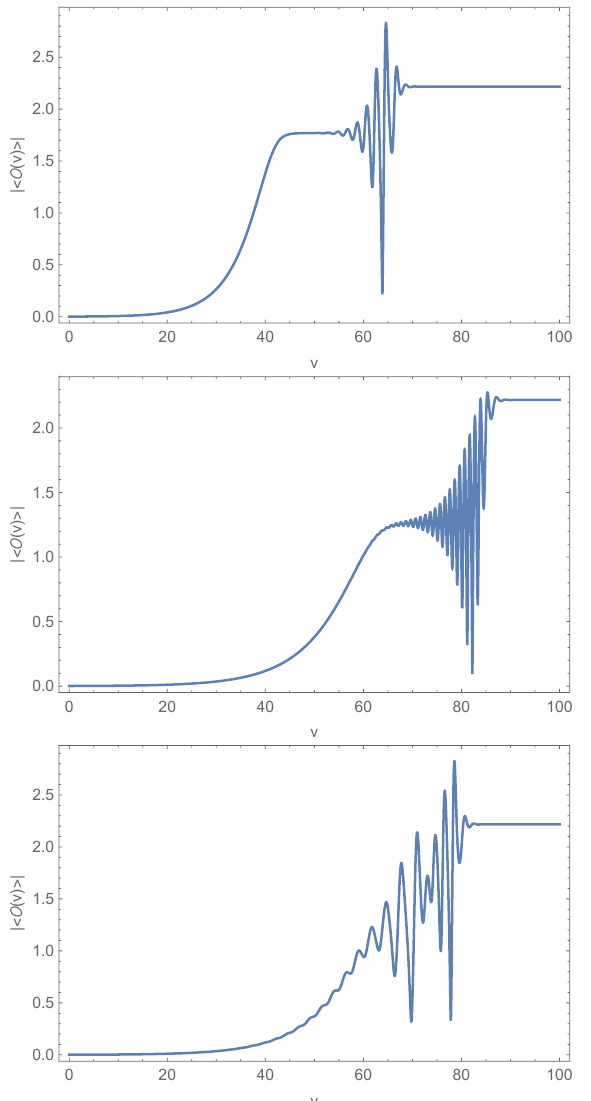
Figure 8 . The time evolutions of superconducting order parameter hOi for Q = 3 . 4 and q = 6 with different initial perturbations. In the three panels, the initial perturbation are taken as the second eigenfunction, the third eigenfunction, and the superposition of the second and the third